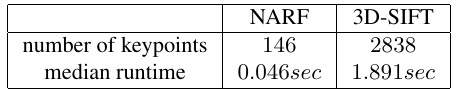
Table 1: Quantitative comparison of NARF and 3D-SIFT